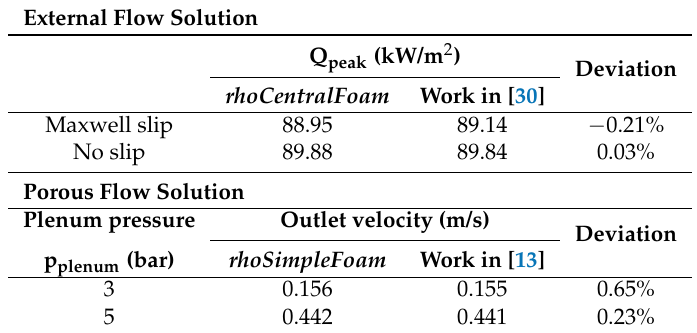
Table 1. Verification of suitability of solvers for argon flow over the cylinder.